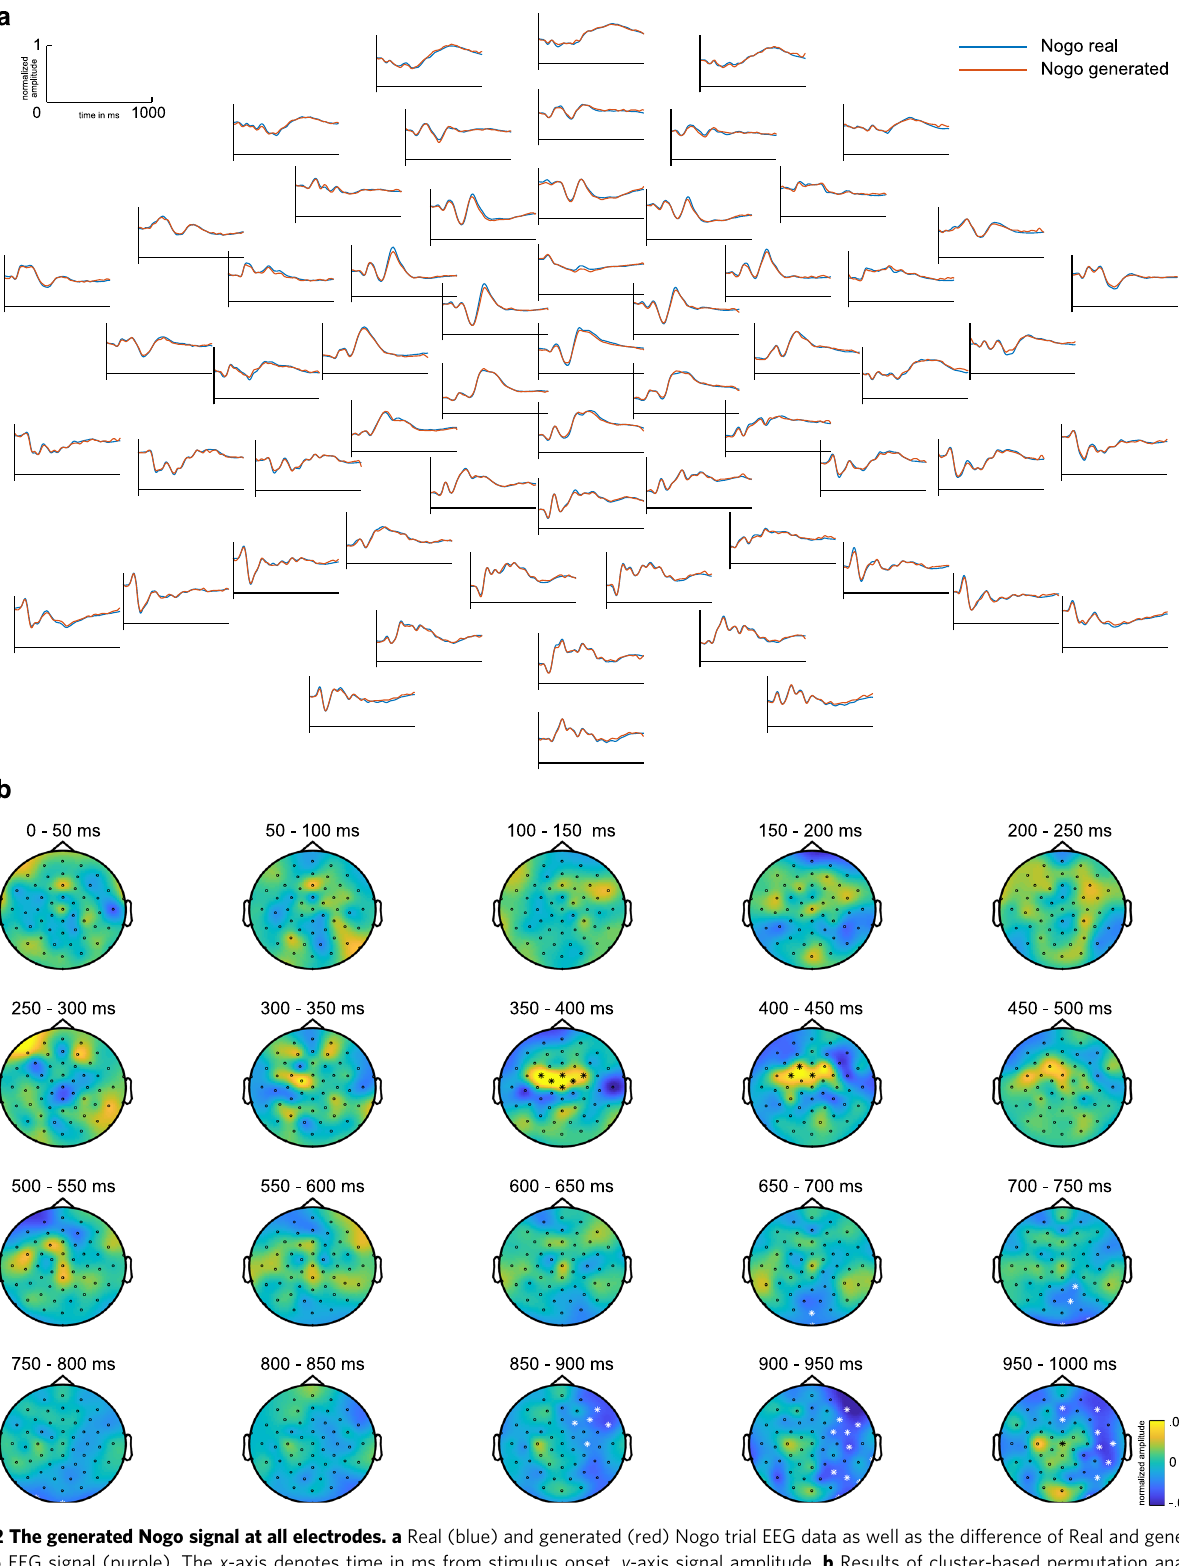
Fig. 2 The generated Nogo signal at all electrodes. a Real (blue) and generated (red) Nogo trial EEG data as well as the difference of Real and generated Nogo EEG signal (purple). The x -axis denotes time in ms from stimulus onset, y -axis signal amplitude. b Results of cluster-based permutation analysis comparing real and generated Nogo signal, aggregated in 50 ms steps. Electrodes showing signi fi cant differences in the respective time step are marked by an asterisk, positive differences by a black, and negative differences by a white asterisk. Colors denote amplitude differences. The fi gures show normalized